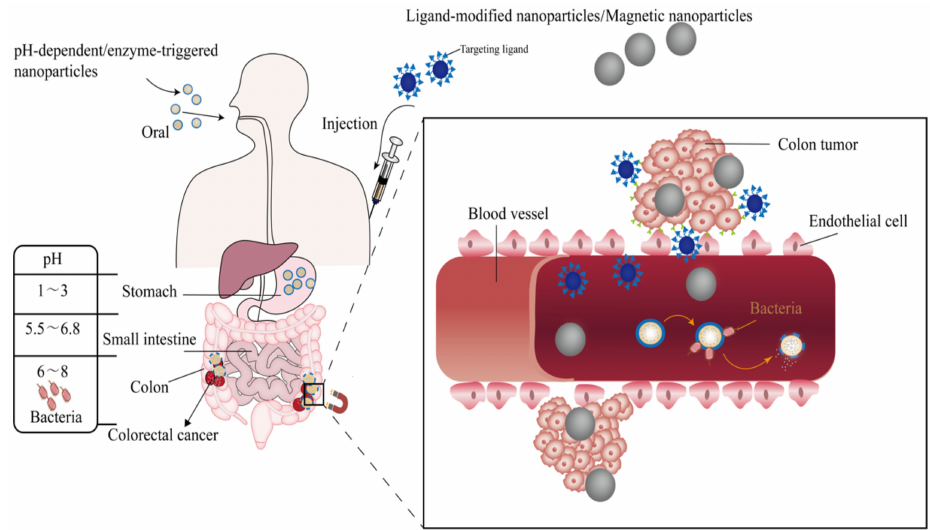
Figure 2. A schematic diagram of some representative targeting